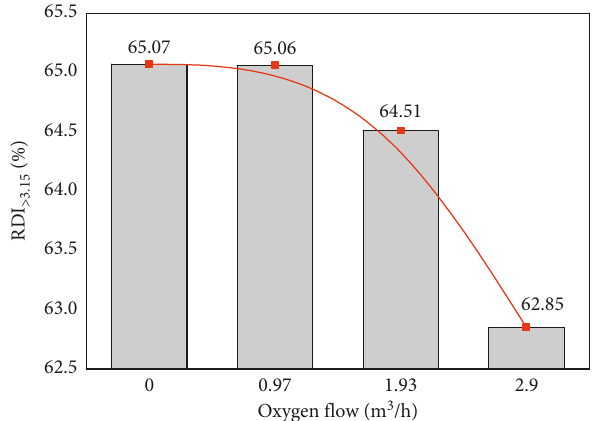
Figure 6: Low-temperature reduction pulverability (RDI 3.15 ) of the sintered ore with different oxygen enrichment loads. > Table 10: Softening performance of the sintered ore with different oxygen enrichment loads. Sample